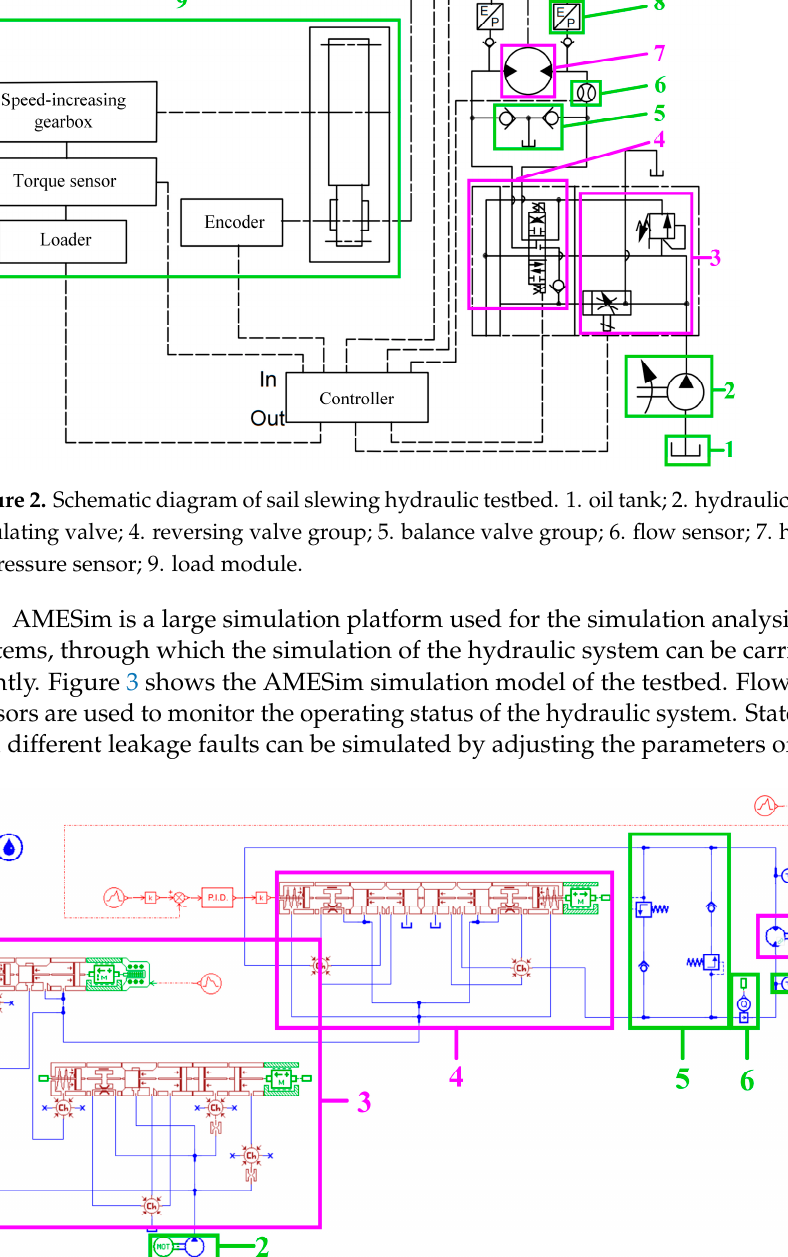
Figure 3. Simulation model of sail slewing hydraulic testbed. 1. oil tank; 2. hydraulic pump; 3. speed regulating valve; 4. reversing valve group; 5. balance valve group; 6. flow sensor; 7. hydraulic motor; 8. pressure sensor; 9. load module.